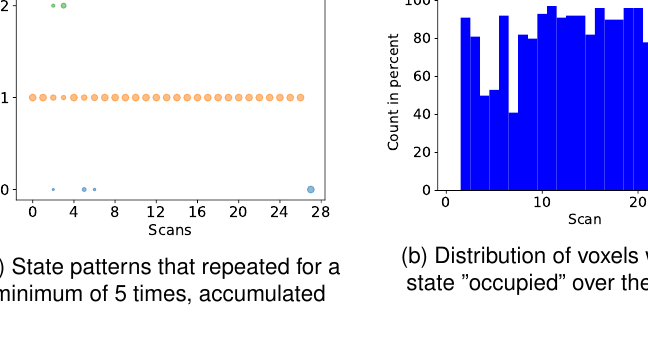
Figure 12. Pattern distribution for a lantern.